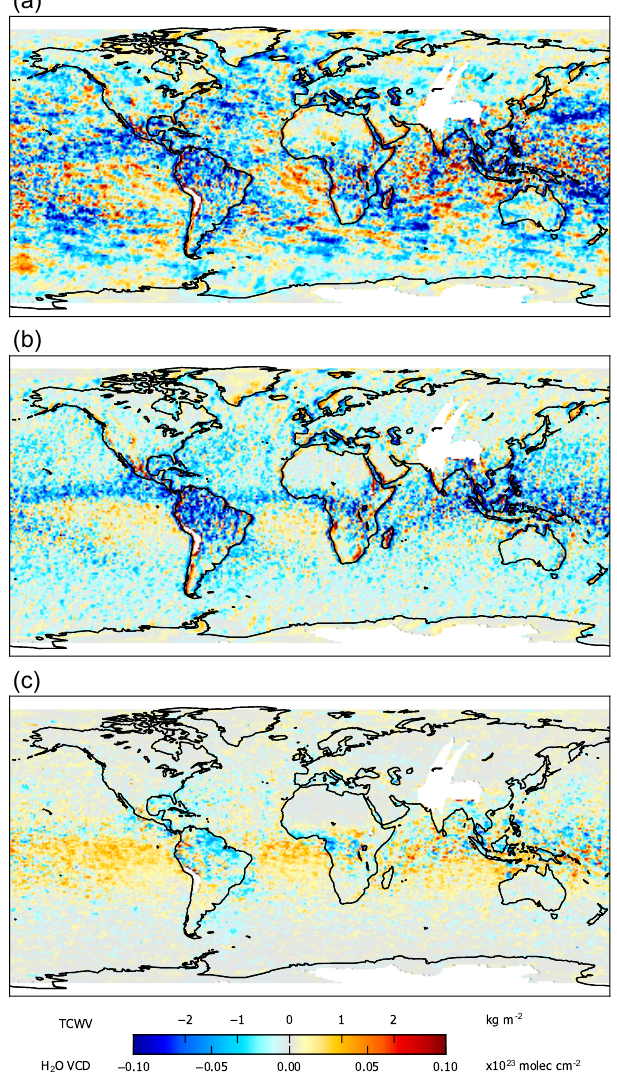
Figure 3. Mean difference of GOME and SCIAMACHY TCWV during the overlap period August 2002 to June 2003 calculated as the mean of monthly means (a) or as mean of coincident measure- ments on orbital basis (b) , (c) . In (a) and (b) , SCIAMACHY data are in original resolution. In (c) , SCIAMACHY pixels are merged to GOME